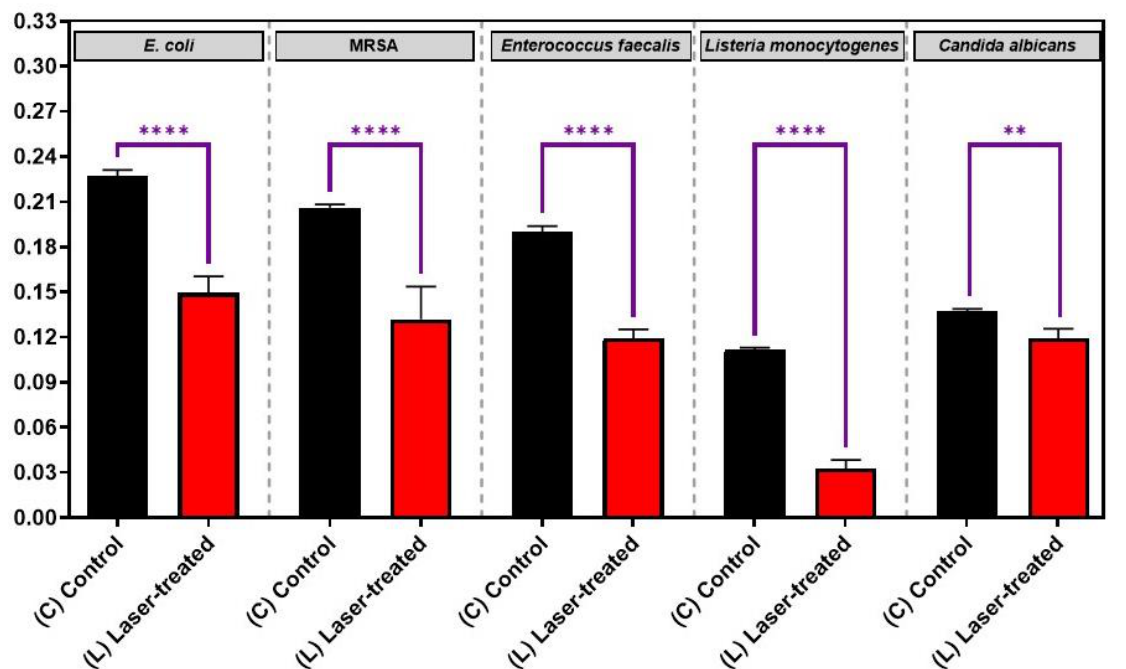
Figure 3. Growth analysis of four different bacterial pathogens: E. coli , Staphylococcus aureus , Enterococcus faecalis , Listeria monocytogenes , and the fungus, Candida albicans , after femtosecond laser treatment with a 400 nm wavelength and an average power of 50 mW for 15 min. Bar graph comparing the growth rate during the log phase of the control culture (C) with that of the bacterial cultures exposed to laser treatment (L). Significance was tested by ANOVA followed by Tukey testing (**** p < 0.0001, ** p < 0.01).